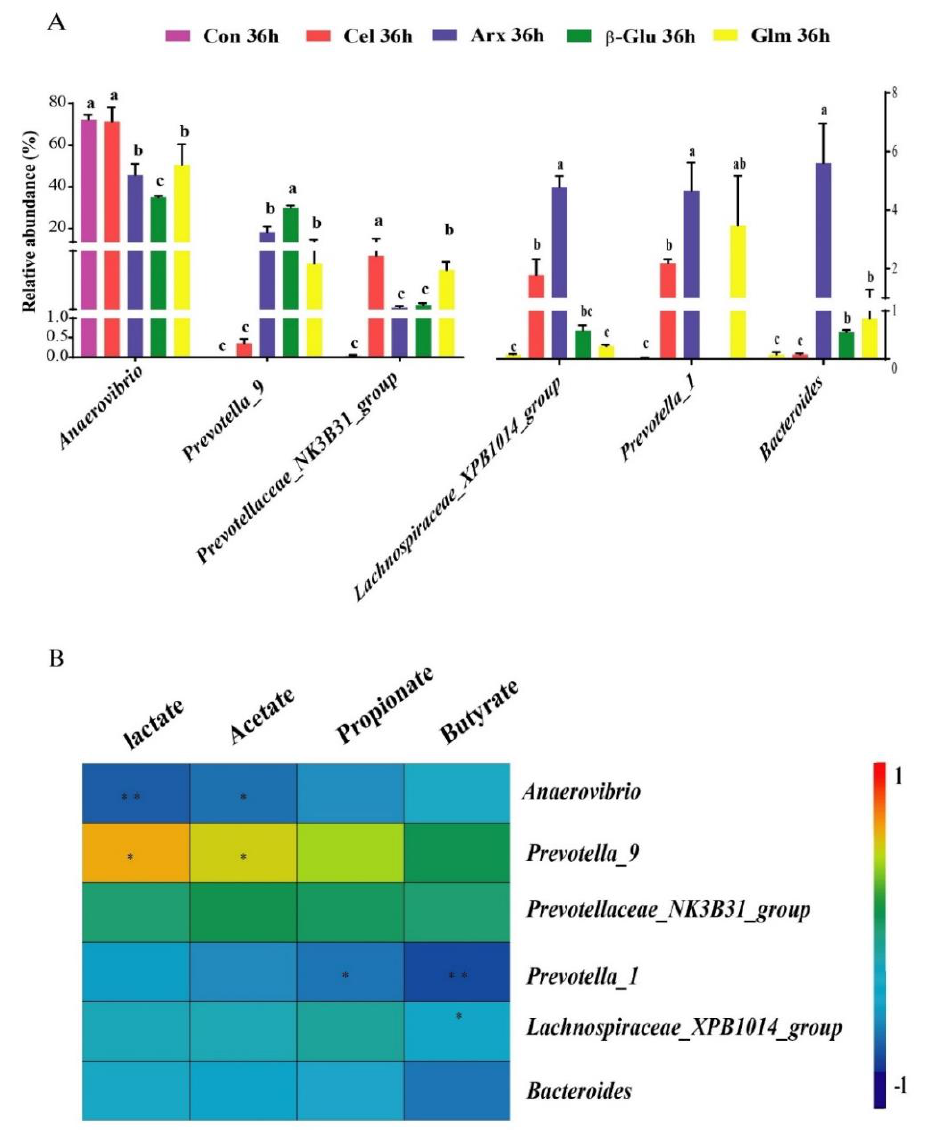
Figure 5. Analysis of the first six differential bacteria among five groups at the genus level and 36 h during fermentation ( A ) (n = 3). The spearman correlation between lactate, SCFA and the first six differential bacteria at 36 h ( B ). All data were analyzed by Kruskal–Wallis ANOVA test and presented as the mean values ( n = 15; Different letters and * mean p < 0.05; ** means p < 0.01; Con, control; Cel, cellulose; Arx, arabinoxylan; β − Glu, β − glucan; Glu, glucomannan).